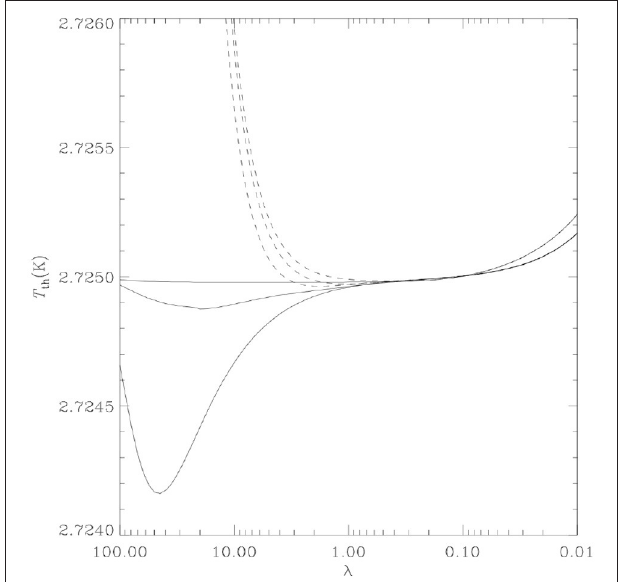
FIGURE 4 | “Distorted spectra in equivalent thermodynamic temperature vs. λ (in cm) with late energy injection 1ε/ε i ≃ 4 y = 5 × 10 − 6 plus an early/intermediate energy injection 1ε/ε i = 5 × 10 − 6 ( ∼ 20 times smaller than current upper limits) at the “time” Comptonization parameter y h = 5,1,0.01 (bottom to top; the cases at y h = 5 and 1 are very similar at short λ ; solid lines) plus a FF distortion with y B = 10 − 6 (dashes).” y h = y , but assuming electron temperature equal to the radiation one and computing the integral “from the energy injection time to the current time.” For a negative value of distortion parameter the shape of the distorted spectrum is almost specular with respect to a horizontal line with T = T 0 to that derived assuming the same absolute, but positive, parameter value. Reprinted from Burigana et al. (2004), Copyright (2004), with permission from Elsevier.